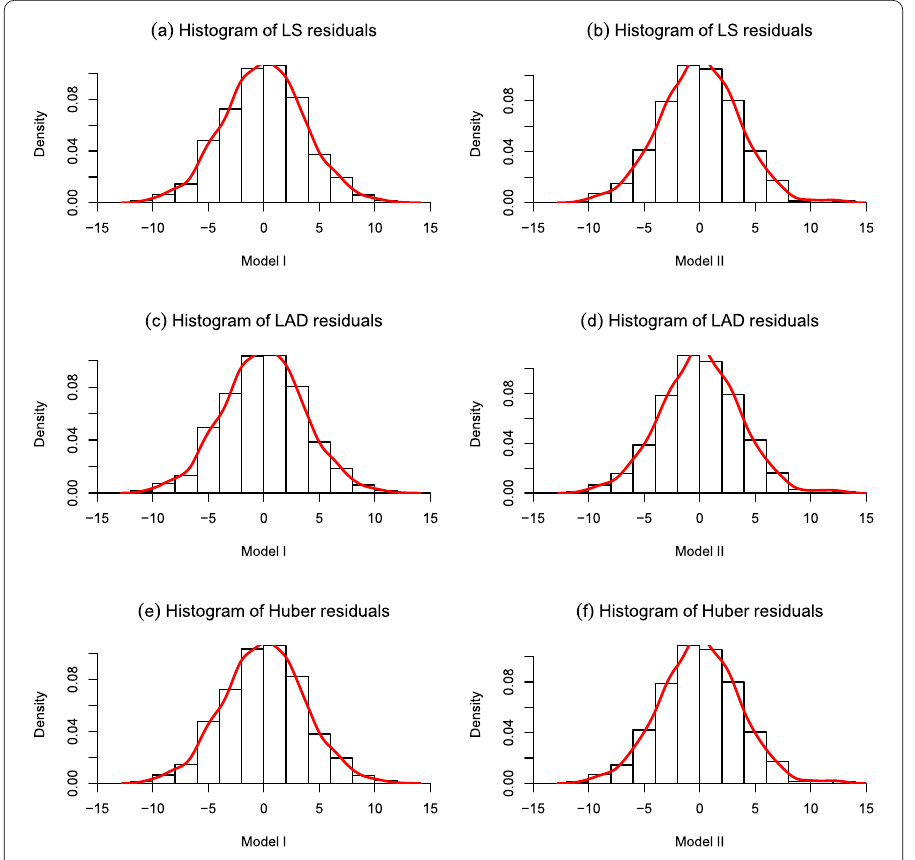
Figure 2 Histograms and fitted distributions of M-estimates residuals with different explanatory variables and M-methods (sample size is n = 1,000).